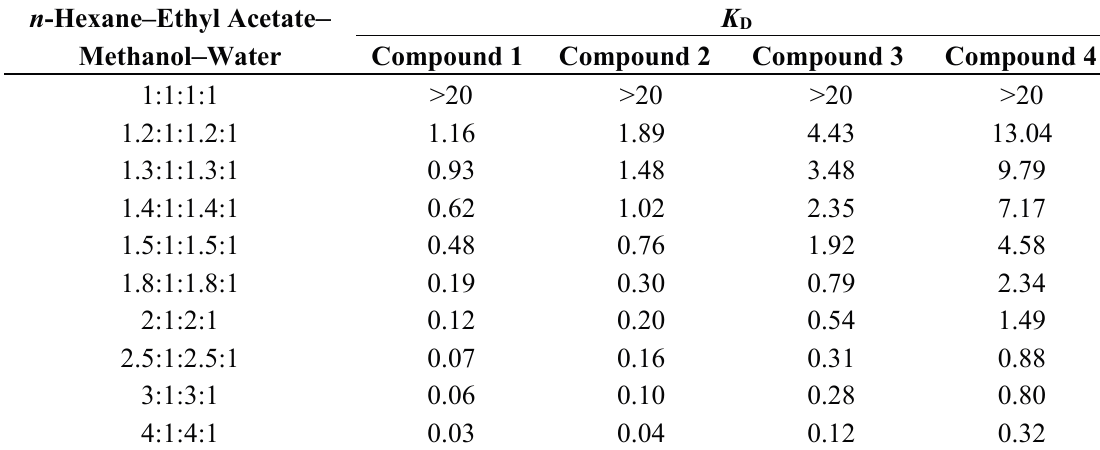
Table 1. K D values of the lignans in different volume ratios of the